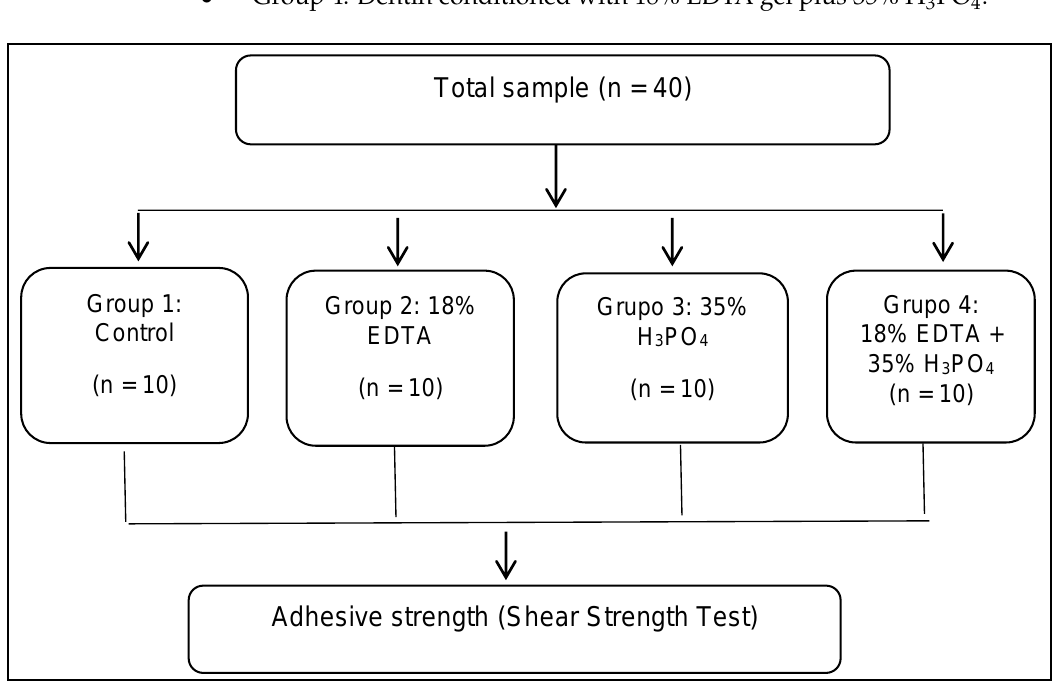
Figure 1. Random distribution of groups according to sample size.